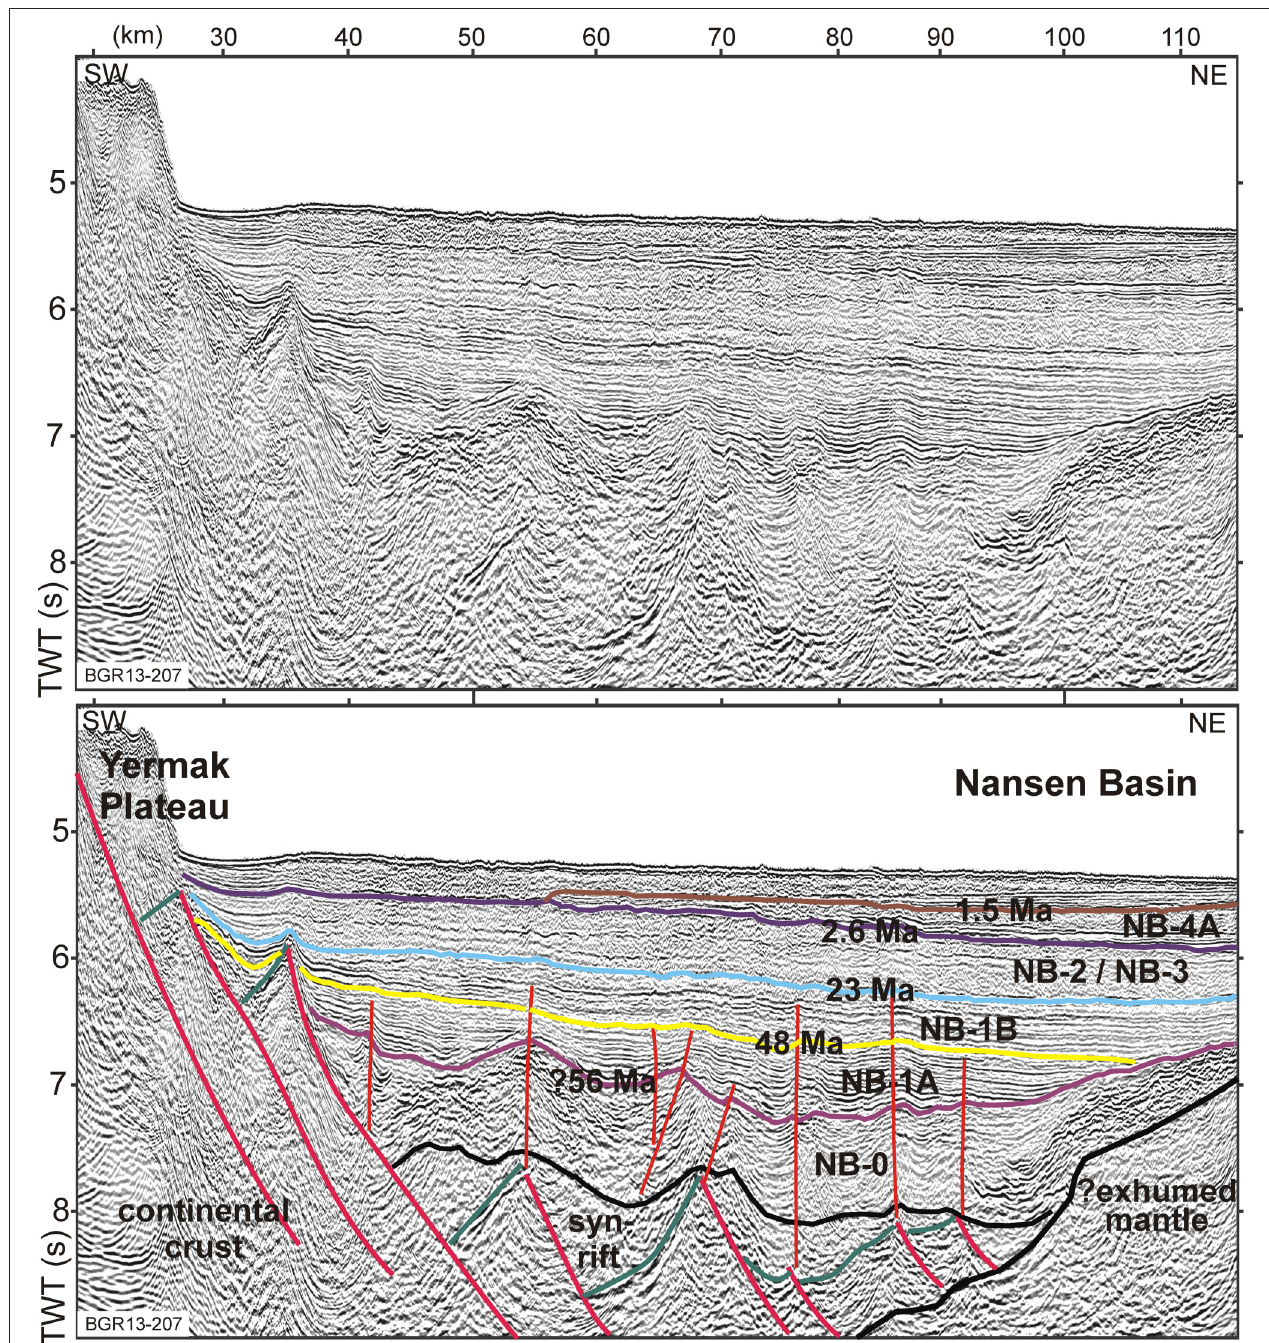
FIGURE 4 | Zoom of the continental margin east of the Yermak Plateau shown in Figure 3. Rift basins developed above rotated basement blocks which are covered by unit NB-0, indicating later subsidence. The steep faults above, affecting units NB-0, NB-1A, and NB1-B, with upwards decreasing deformation, are caused by a transpressional regime ending during deposition of unit